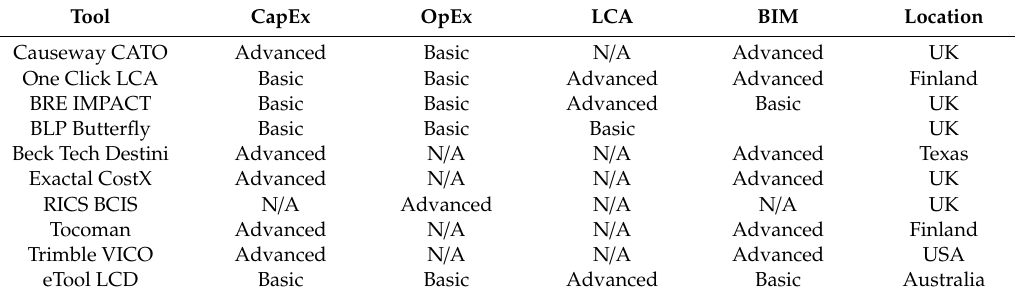
Table 3. Comparison of Whole Life Costs (WLC) estimation software